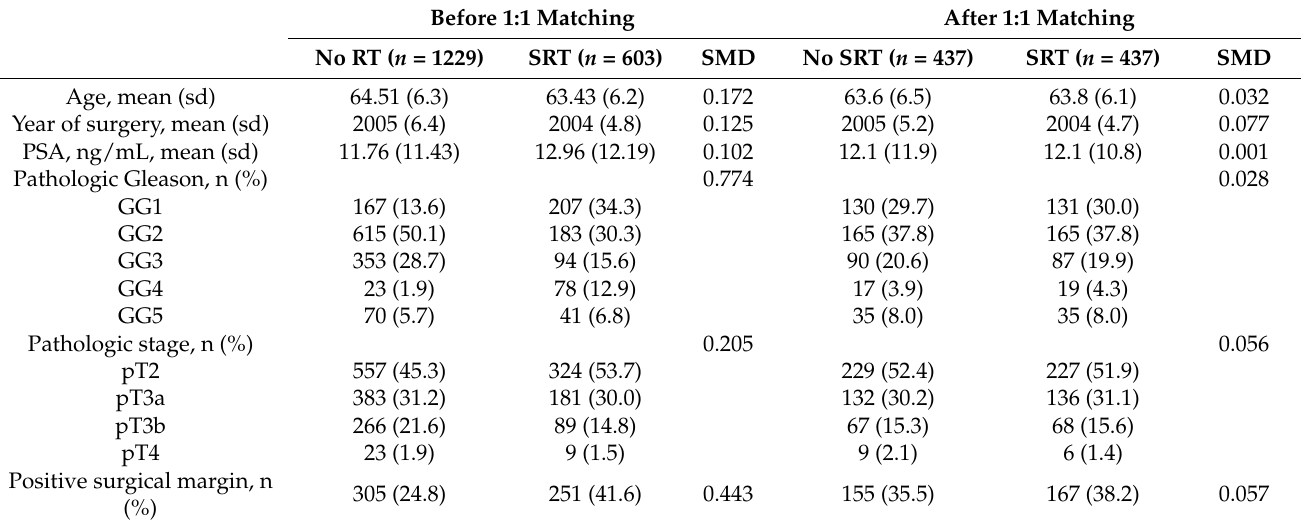
Table 1. Descriptive tumor characteristics of RP patients with BCR stratified according to no RT and SRT, before and after 1:1